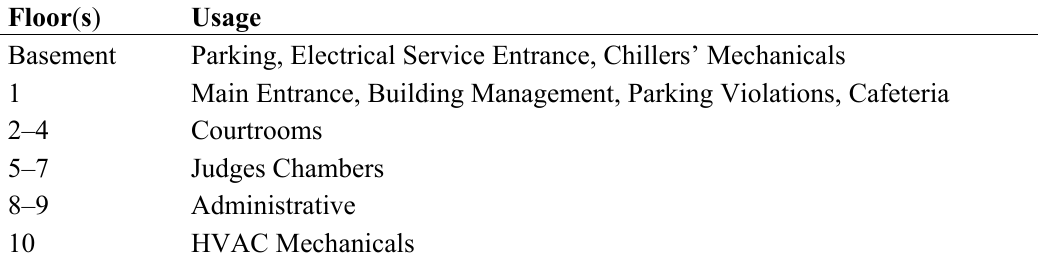
Table 1. Courthouse services by